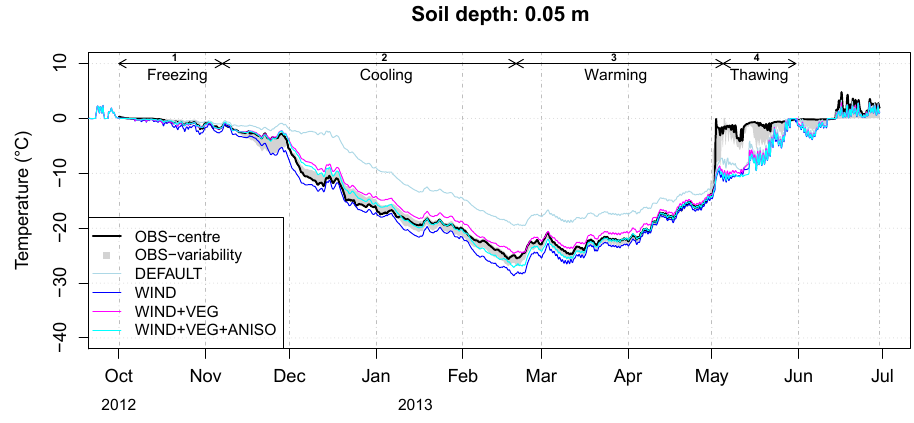
Figure 9. As for Fig. 8 but with radiative transfer in snow switched off and the air layer scenario added to the WIND + VEG + ANISO option.